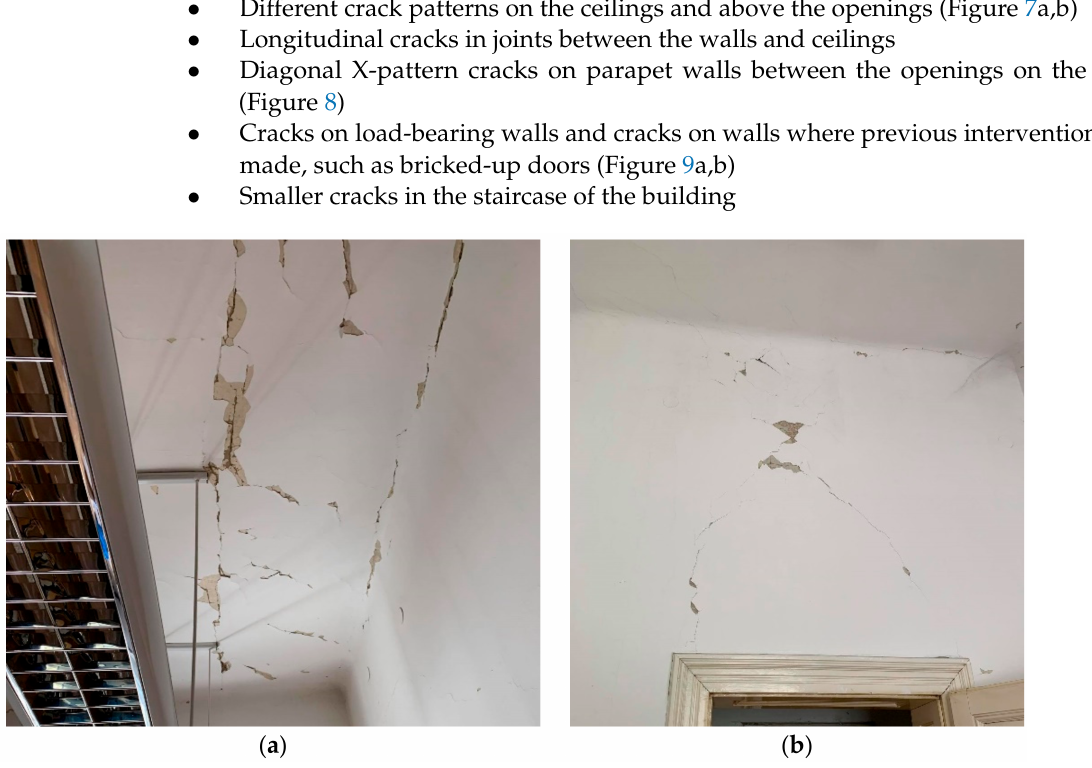
Figure 7. Cracks in the ceiling ( a ) and above the openings ( b ) on the 2nd floor.